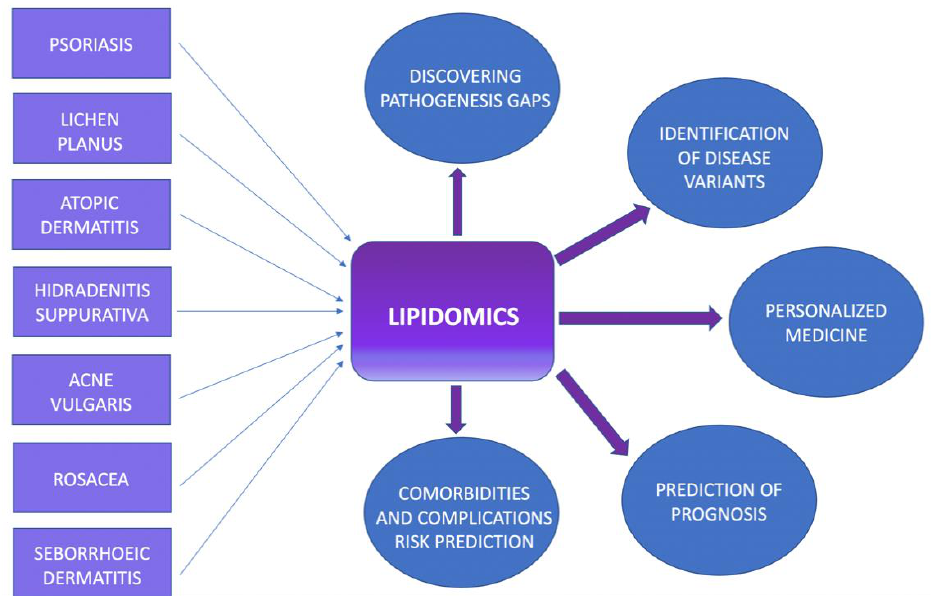
Figure 2. Diagram showing the benefits of analyzing lipidomics in the context of selected inflam- matory skin diseases.